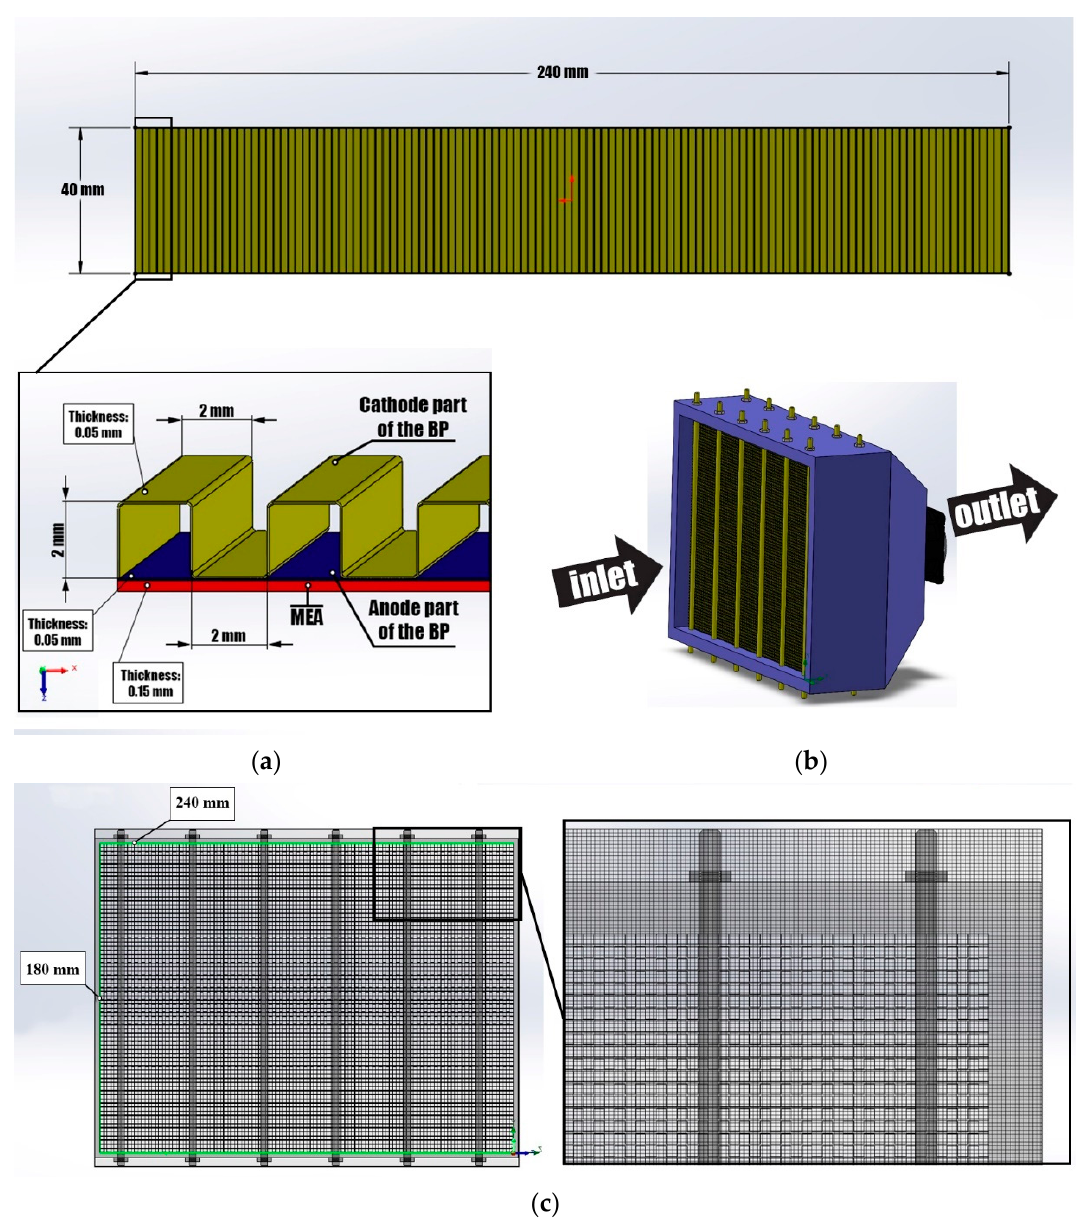
Figure 3. ( a ) Bipolar plate model; ( b ) PEMFC stack model; ( c ) PEMFC stack model with mesh. The air movement and supply of clean air is carried out by mechanical means. The cooling and oxidizer supply system is made in the form of two fans installed in the PEMFC stack body at a distance of 60 mm from the stack exit. When the cooling and oxidizer supply system is activated, air flows are evenly distributed over the entire inner surface of the PEMFC stack in BP gas distribution channels. Thus, on the front side of the PEMFC stack, the cooling and oxidizer agent is taken in and evenly distributed along the distri- bution channels, and air comes out from the exit from the PEMFC stack, which already takes part in the process of obtaining energy from hydrogen. Figure 4 shows the temperature field’s distribution in PEMFC stack, taking into ac- count previously obtained data.